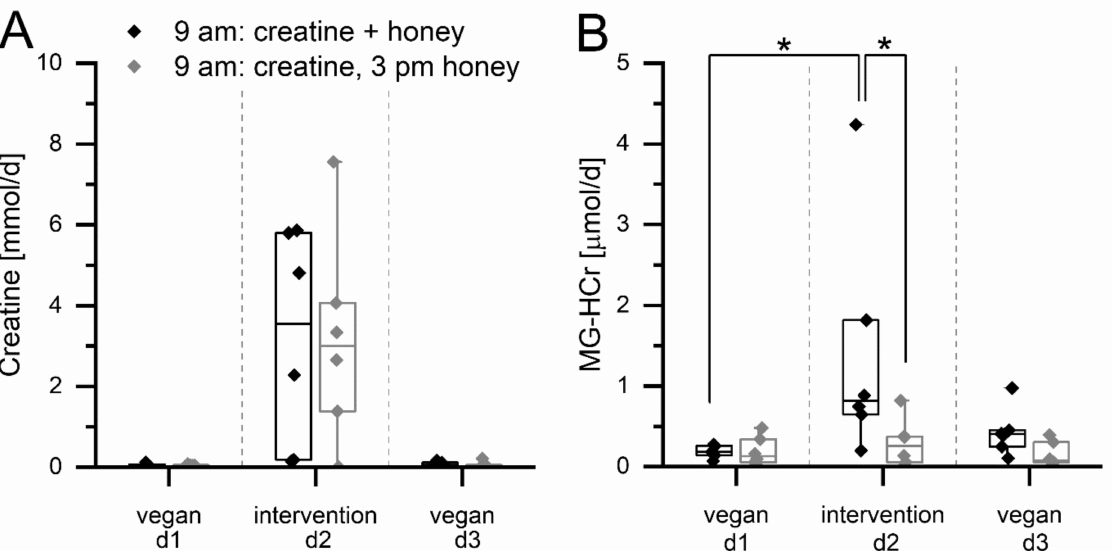
Figure 2. Excretion of creatine ( A ) and MG-HCr ( B ) in 24 h urine samples of 12 volunteers during a three day study with an intervention on day 2. Intervention: Simultaneous ingestion group (black): 2.5 g of creatine monohydrate + 65 g of Manuka honey (43 mg MGO) + 3 crispbreads at 9 a.m., separate ingestion group (grey): 2.5 g of creatine monohydrate at 9 a.m. and 65 g of Manuka honey (43 mg MGO) and 3 crispbreads at 3 p.m. Significance: * p < 0.05. On the other hand, the excretion of MG-HCr increases from 0.18 ± 0.08 µ mol/d (SIM group) and 0.19 ± 0.19 µ mol/d (SEP group) to 1.4 ± 1.5 µ mol/d (SIM group)